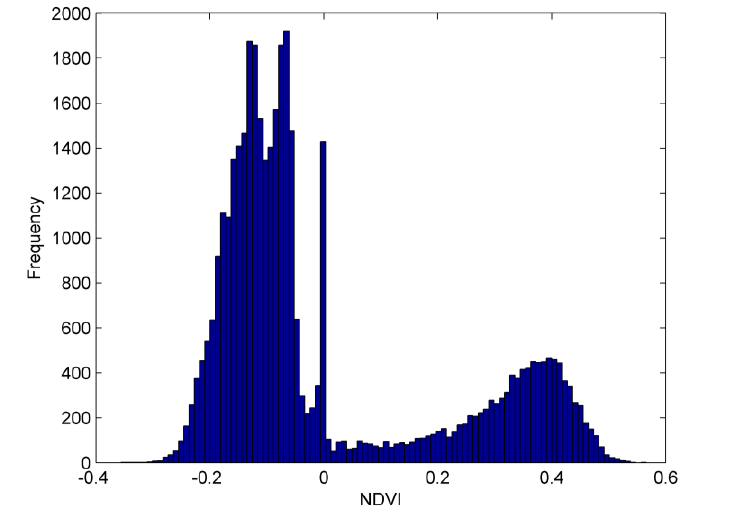
Figure 9. Histogram of NDVI values of high-rise